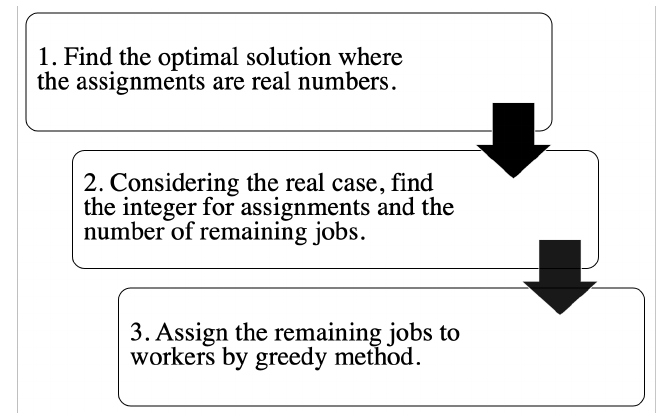
Figure 2. Flowchart of the